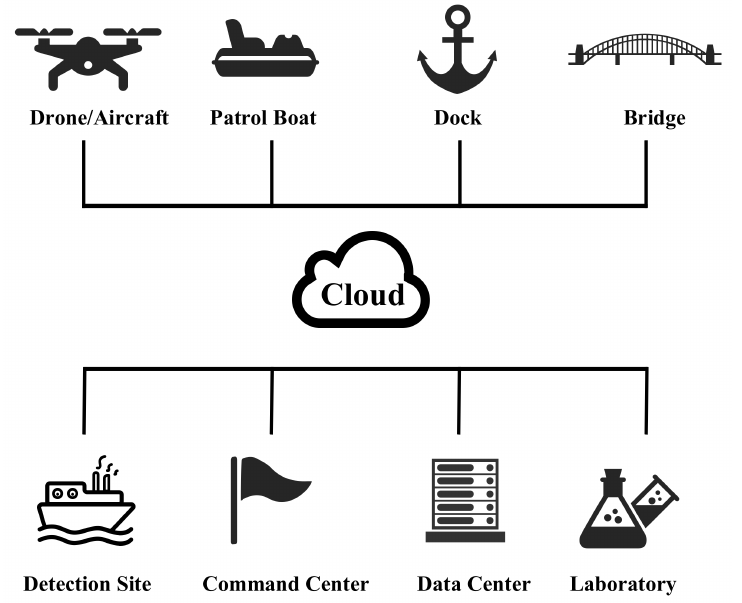
Figure 1. System overview